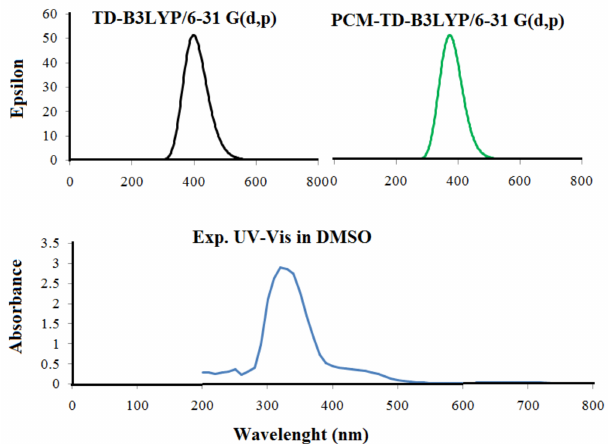
Figure 2. Comparative experimental and theoretical UV/Vis spectra.